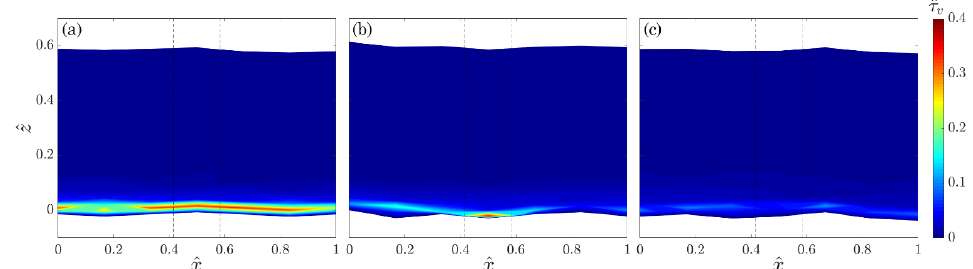
Figure 4. Contours of dimensionless viscous shear stresses measured on the vertical central plane for ( a ) Run 1, ( b ) Run 2, and ( c ) Run 3. The black broken lines indicate the edge of the vegetation stem.